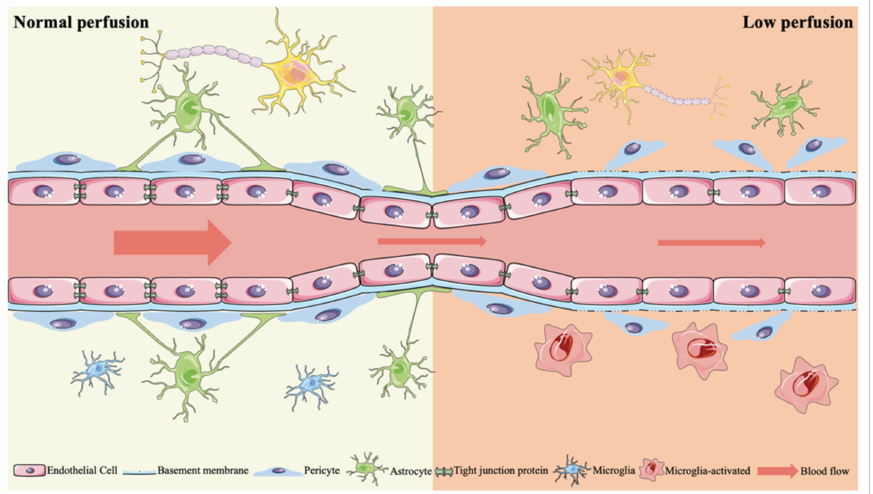
Figure 1. VCID induced by chronic cerebral